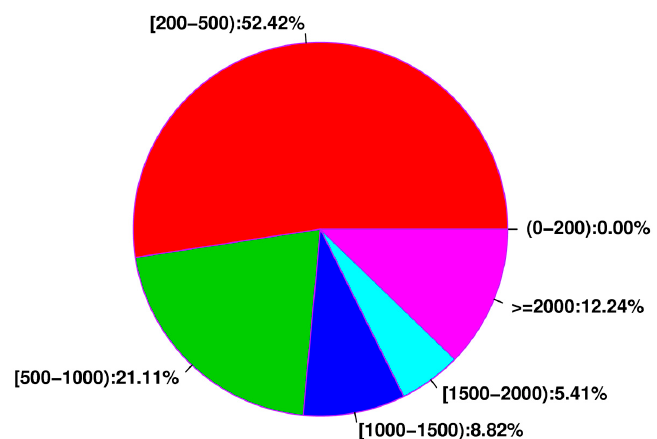
Figure 1. Unigene size distribution. Unigene sizes were calculated, and their relative distribution (%) according to size (bp) are shown.